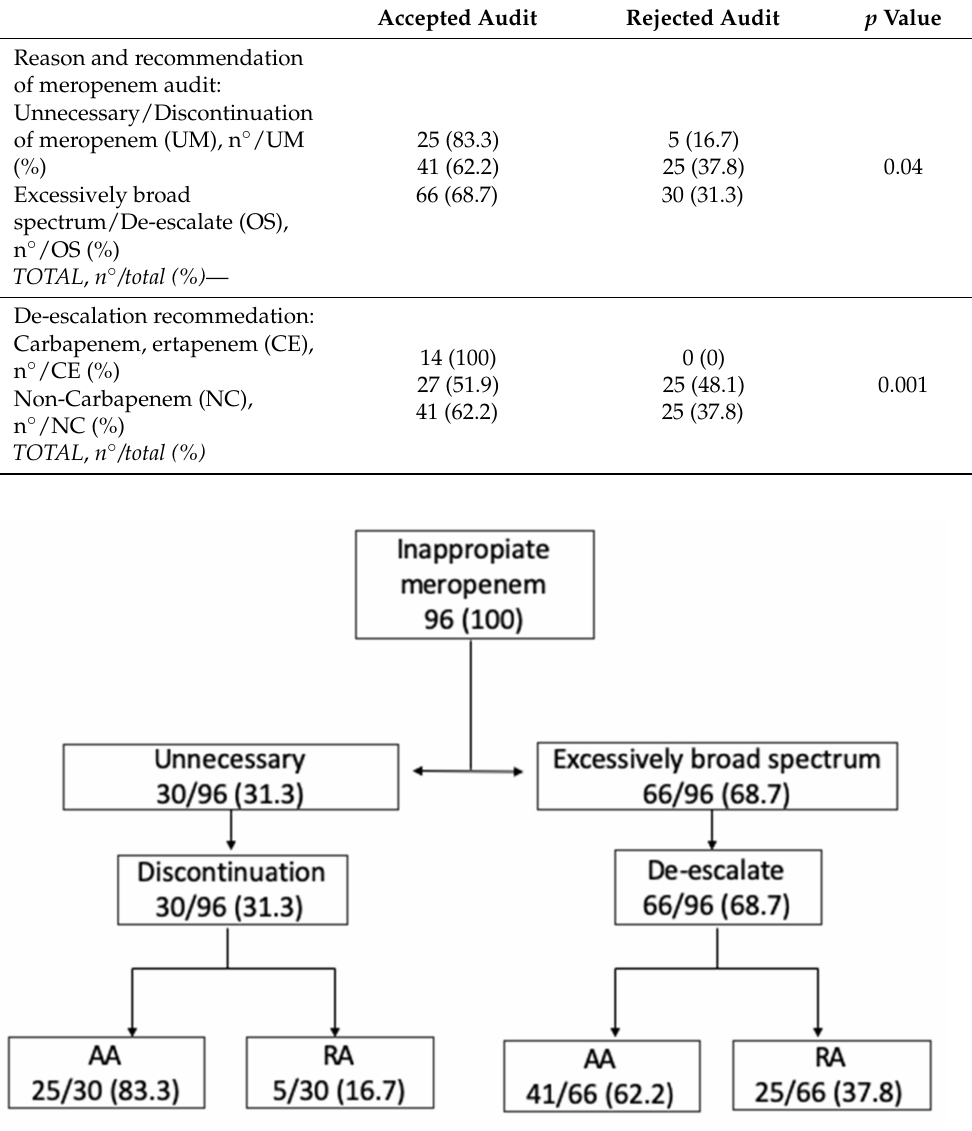
Figure 2. Antimicrobial Stewardship Program meropenem intervention and recommendation, no.